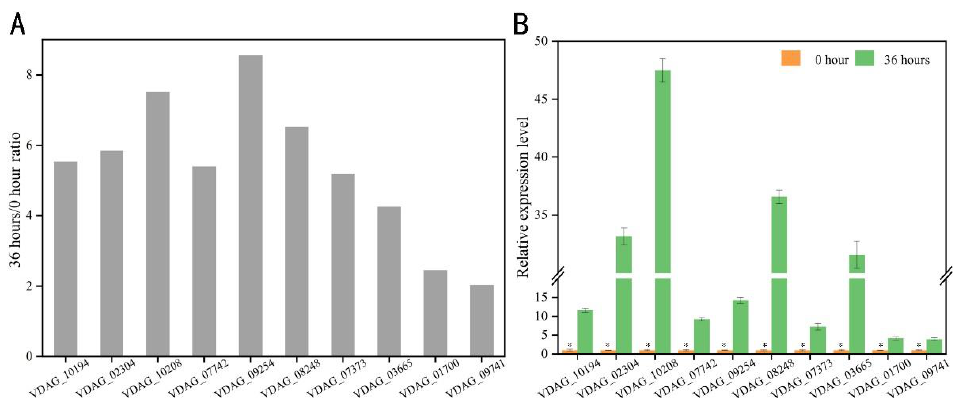
Figure 4. Real-time quantitative PCR (qRT-PCR) verification of proteins whose expression was upregulated at 0 and 36 h after Verticillium dahliae infection in potatoes. ( A ) Relative expression level ratios of 10 randomly selected proteins at 36/0 h in the proteomic data; ( B ) the relative expression was verified at the mRNA level using β -tubulin as a reference gene. Values on the vertical axis represent means ± standard error (SE) of three biological replicates. Asterisks represent significant differences relative to 0 h, as determined by the least significant difference (LSD) test at p = 0.05.